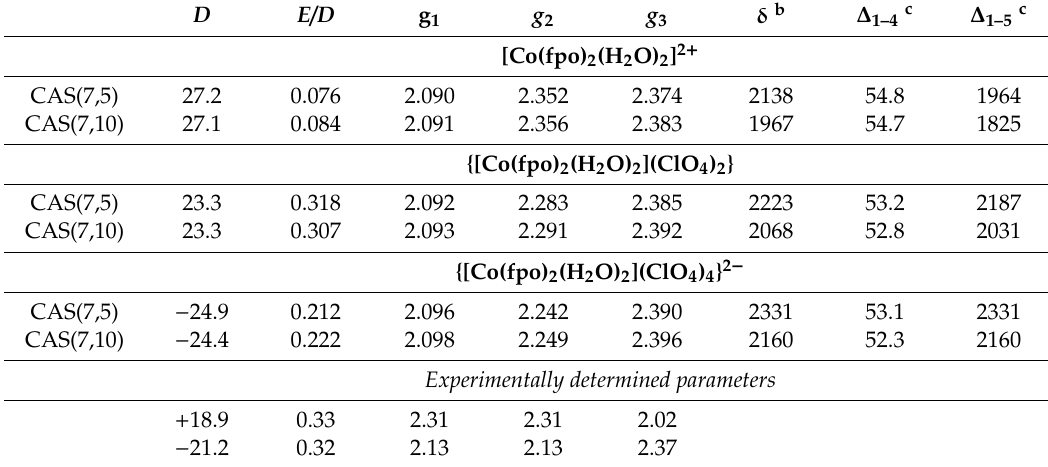
Table 3. Comparison of the spin Hamiltonian parameters for 2 derived from CASSCF / NEVPT2 calculations done in ORCA and the experimental magnetic data a